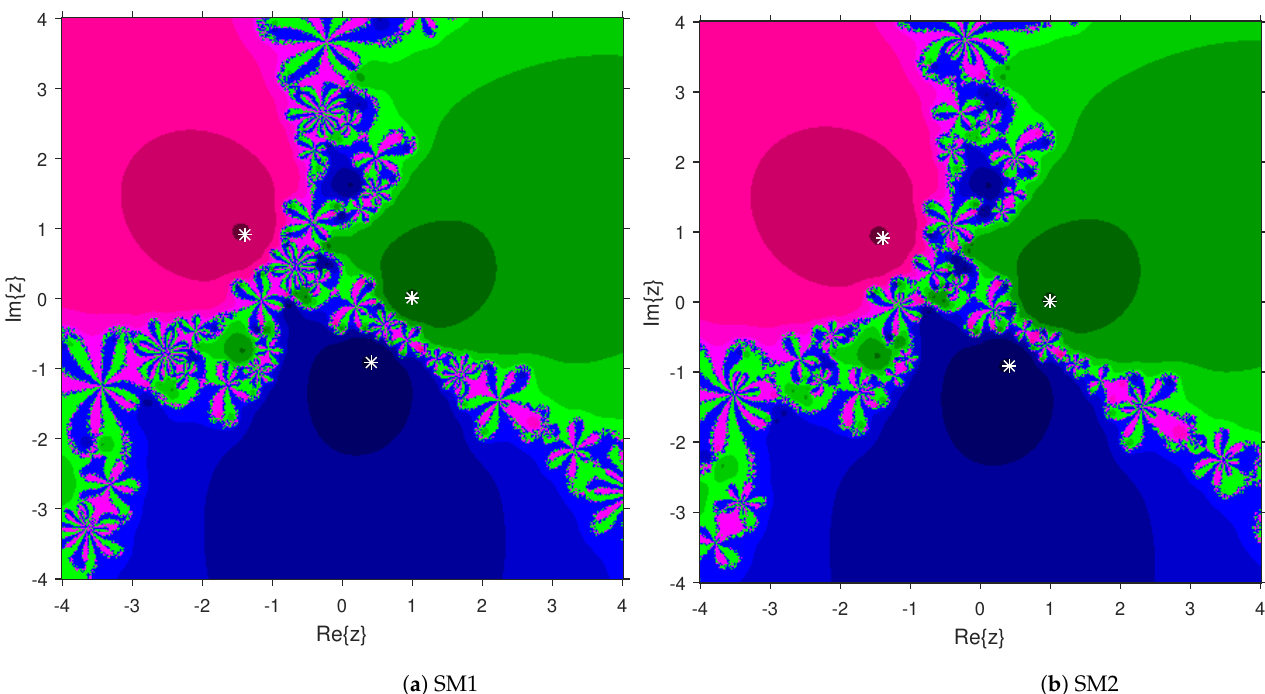
Figure 4. Attraction basins comparison between SM1 and SM2 corresponding to M 4 ( z )